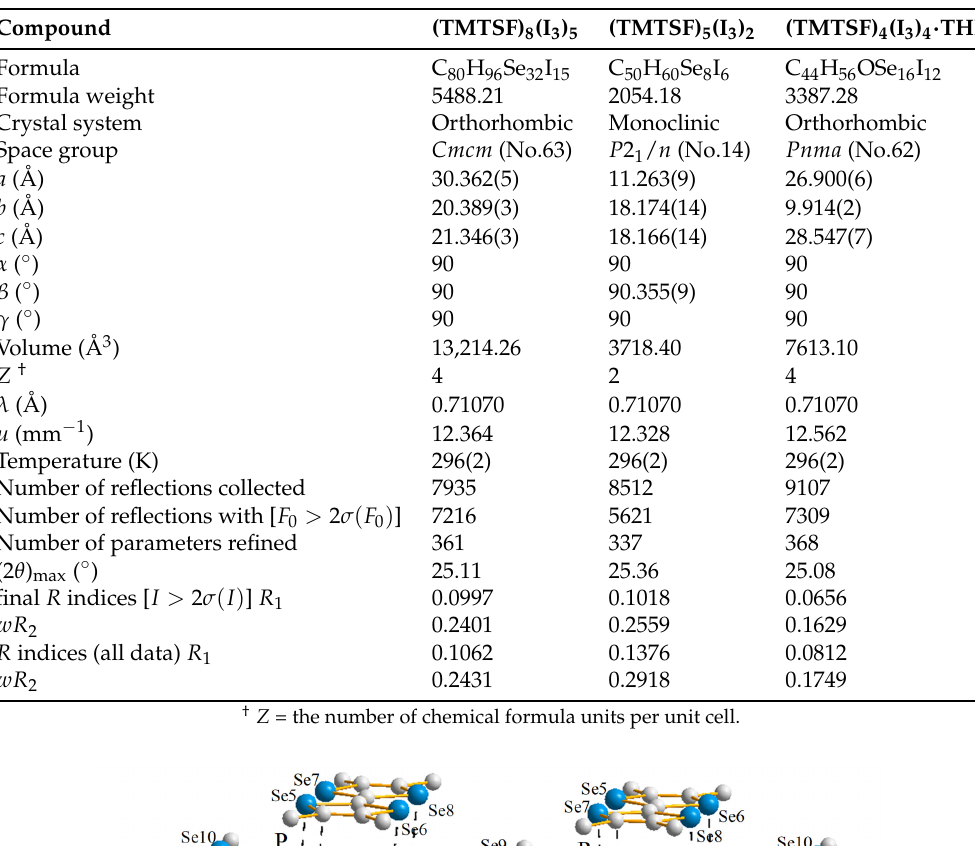
Table 1. X-ray crystallographic and refinement data for (TMTSF) 8 (I 3 ) 5 , (TMTSF) 5 (I 3 ) 2 , and (TMTSF) 4 (I 3 ) 4 · THF, respectively.